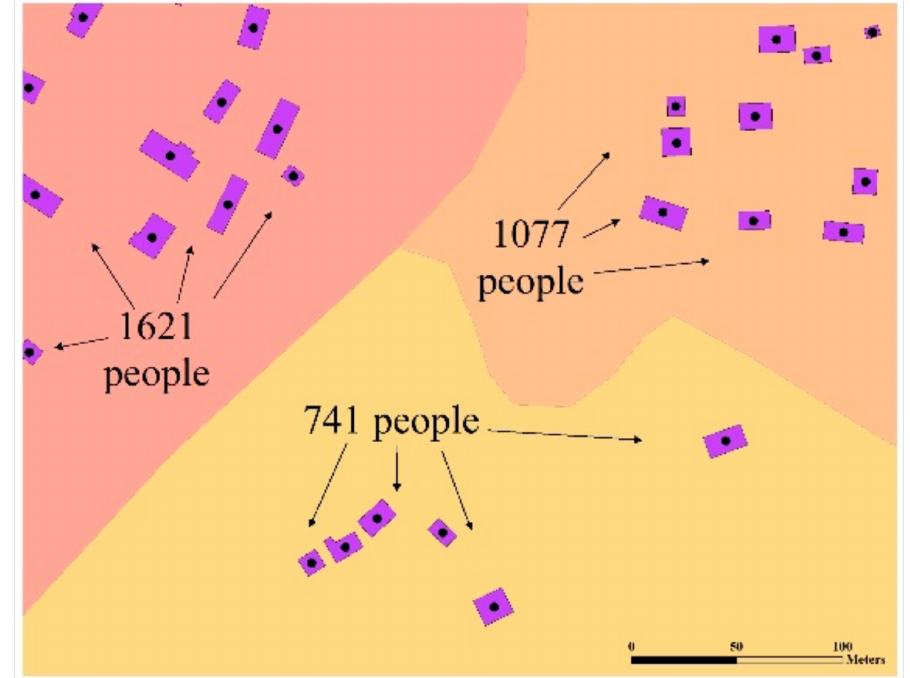
Figure 5. Example area showing three different U.S. census block groups and their total population, divided among the centroids (black dots) of building footprints (purple polygons) to generate the population kernel density map.